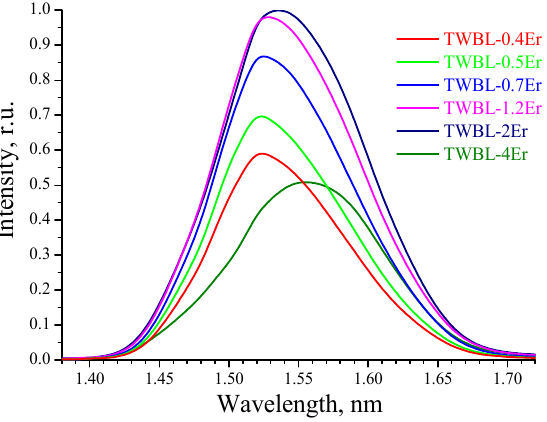
Figure 7. Luminescence band of Er 3+ with peak at 1.53 µm of the TeO 2 -WO 3 -Bi 2 O 3 -(4-x)La 2 O 3 -xEr 2 O 3 glasses with different Er 2 O 3 contents.